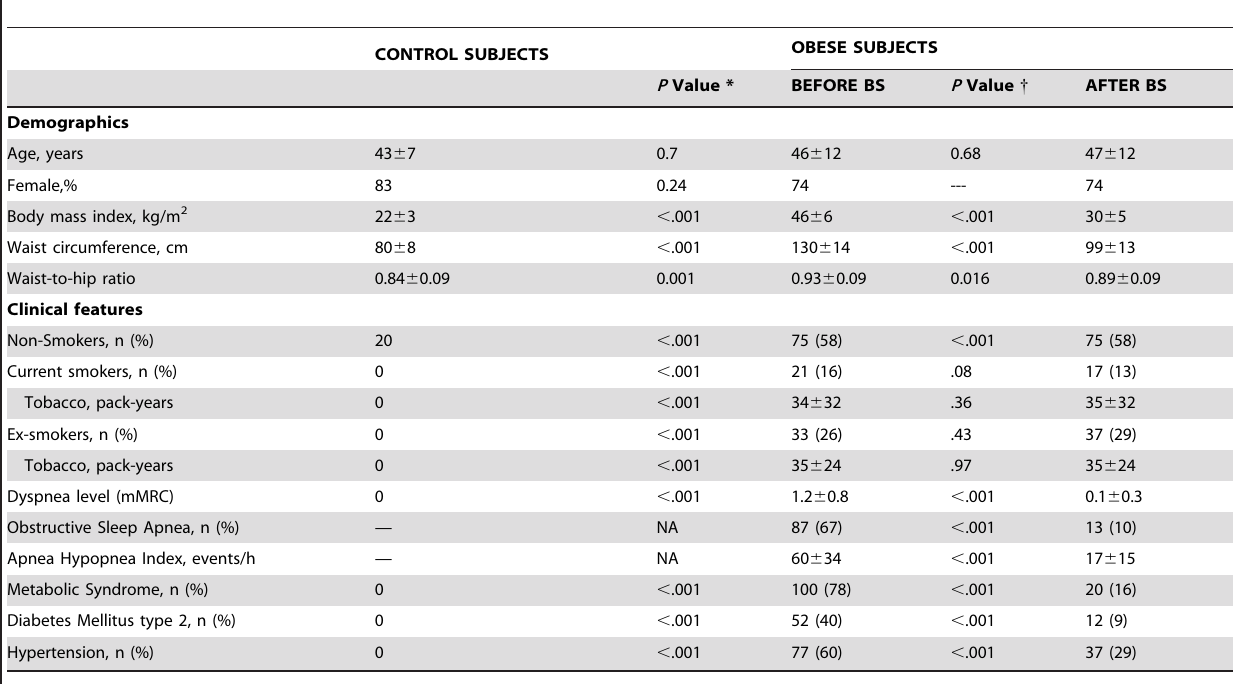
Table 1. Main demographic and clinical characteristics of control and obese participants (mean 6 SD or n